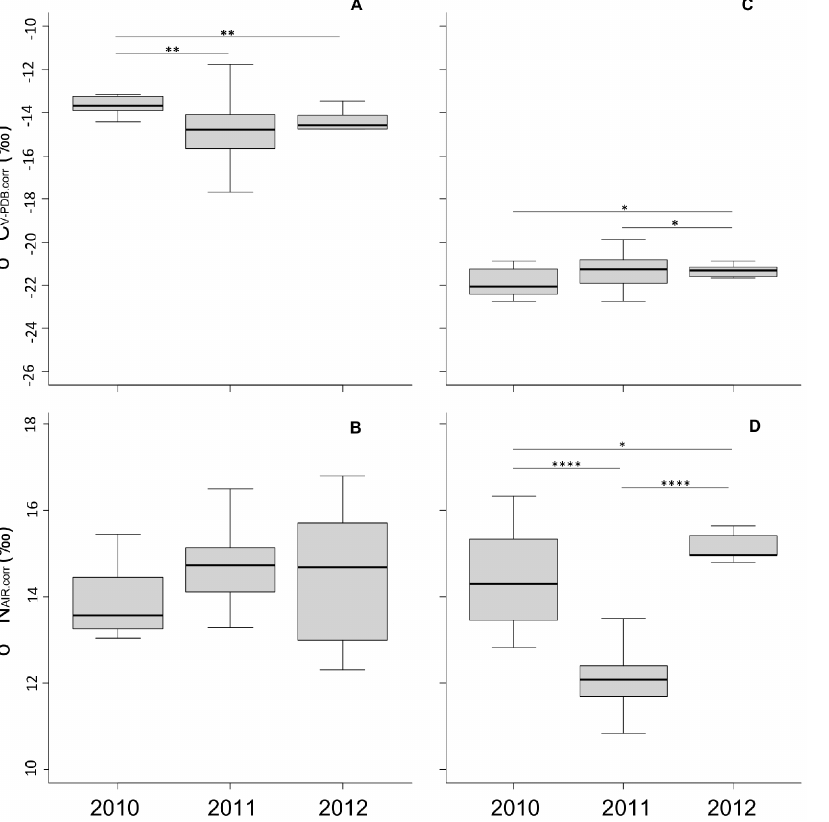
Figure 2. Mean ( ± s.d) of the yearly mean stable carbon isotope tissue composition of A gemsbok and C springbok. B and D represent the yearly mean nitrogen isotope composition of gemsbok and springbok tissues, respectively. The levels of significant differences are shown (*p , 0.05, **p , 0.01, ***p , 0.001, ****p , 0.0001). doi:10.1371/journal.pone.0072190.g002 PLOS ONE |